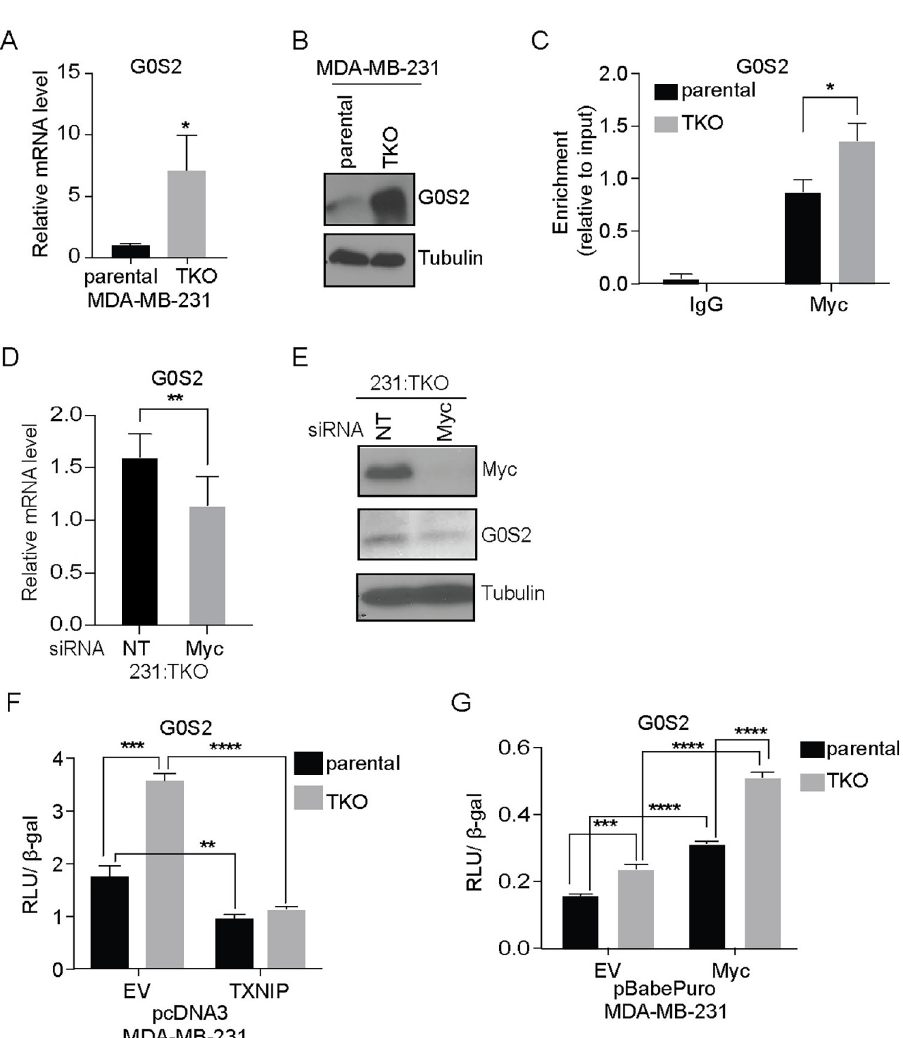
Fig 4. G0S2 is reciprocally regulated by TXNIP and Myc. ( A ) Human G0S2 (G0S2) mRNA levels in parental 231 and 231:TKO cells were measured using RT-qPCR. ( B ) Levels of G0S2 and tubulin in parental 231 and 231:TKO cells were determined using western blotting. ( C ) We performed Myc ChIP-qPCR to measure Myc occupancy upstream of the G0S2 TSS using 3 biological replicates of parental 231 and 231:TKO cells. Statistical significance was determined using a t test. � p < 0.05. ( D and E ) G0S2 mRNA ( D ) and protein ( E ) levels in 231:TKO cells were measured using RT-qPCR and western blotting following siRNA-mediated Myc knockdown for 48 hours. ( F ) Luciferase activities from a G0S2 luciferase reporter in lysates from parental 231 and 231:TKO cells with ectopic human TXNIP expression from pcDNA3 vector or pcDNA3 EV were measured. Luciferase activity was normalized to the β -gal activity. ( G ) Luciferase activities from a G0S2 luciferase reporter in lysates from parental 231 and 231TKO cells with ectopic human Myc expression from pBabePuro vector or pBabePuro EV were measured. For F and G, values are reported as mean